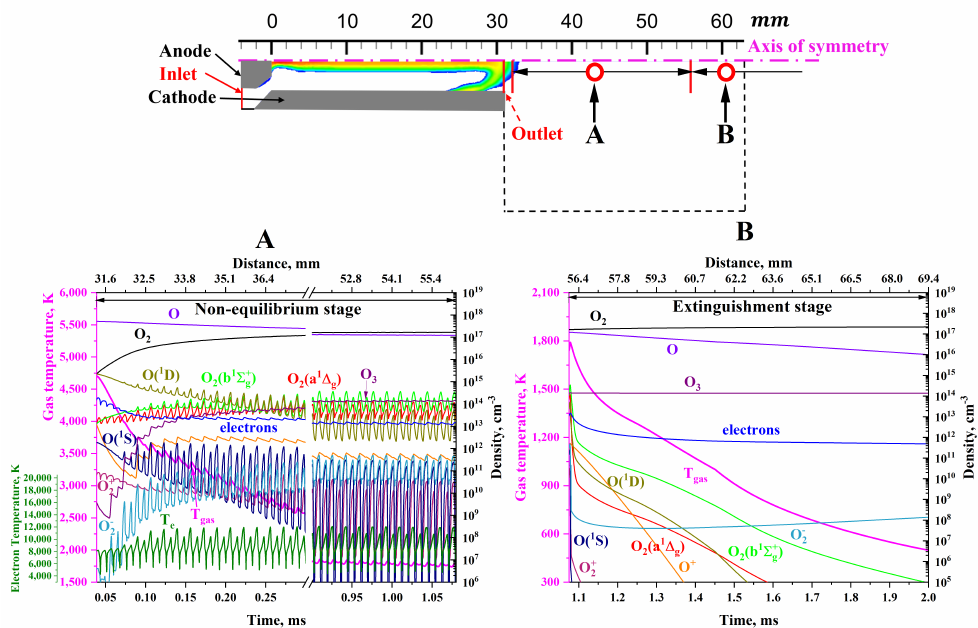
Figure 12. The density evolution of plasma species contaning the oxygen element in the non– equilibrium and extinguishment stages. The structure schematic of the gliding arc is shown in the figure. The distance represents the distance between the head of the gliding arc and the anode at this moment captured using a high-speed camera. ( A ), Non–equilibrium stage, ( B ) Extinguishment stage.